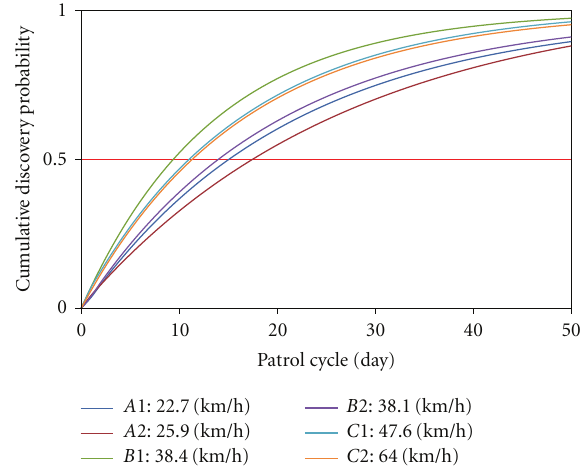
Figure 3: Cumulative discovery probability in the Poisson-Gamma